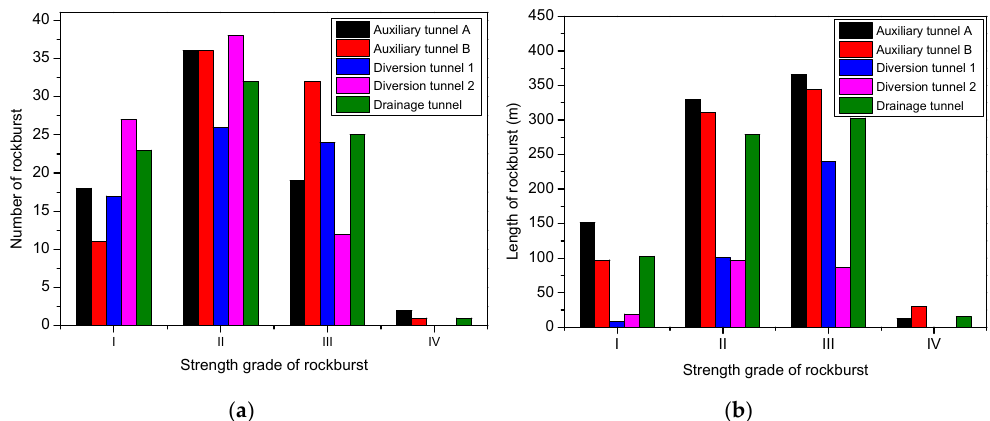
Energies 2018 , 11 , x